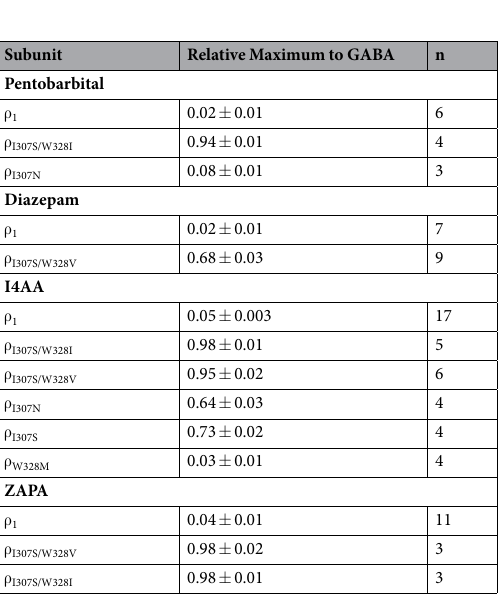
Table 3. The current maxima for pentobarbital, diazepam, I4AA, and ZAPA relative to that of GABA in the ρ 1 and ρ 307/328 mutants. All data are presented as the mean ± standard error